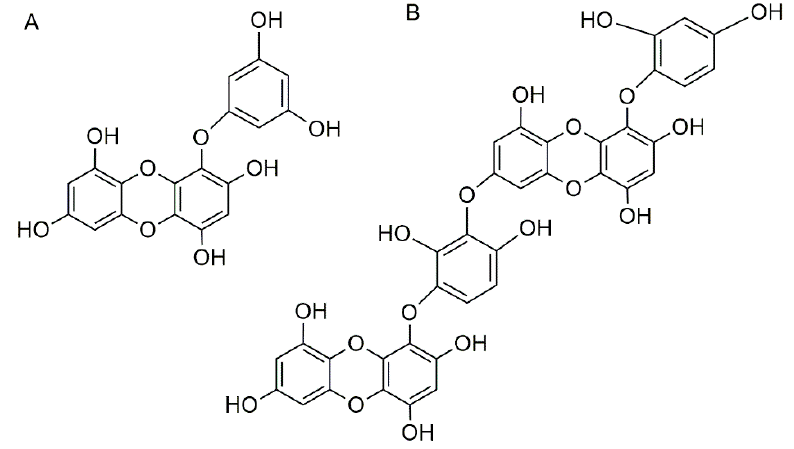
Figure 5. Chemical structure of ( A ) eckol and ( B ) dieckol.